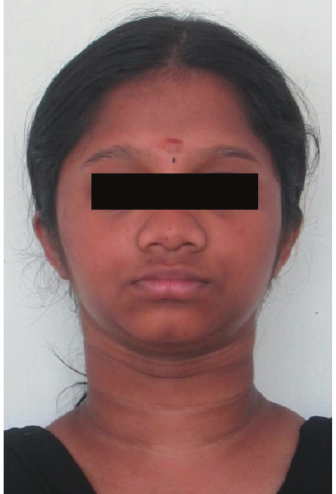
Figure 1: Height of the patient.